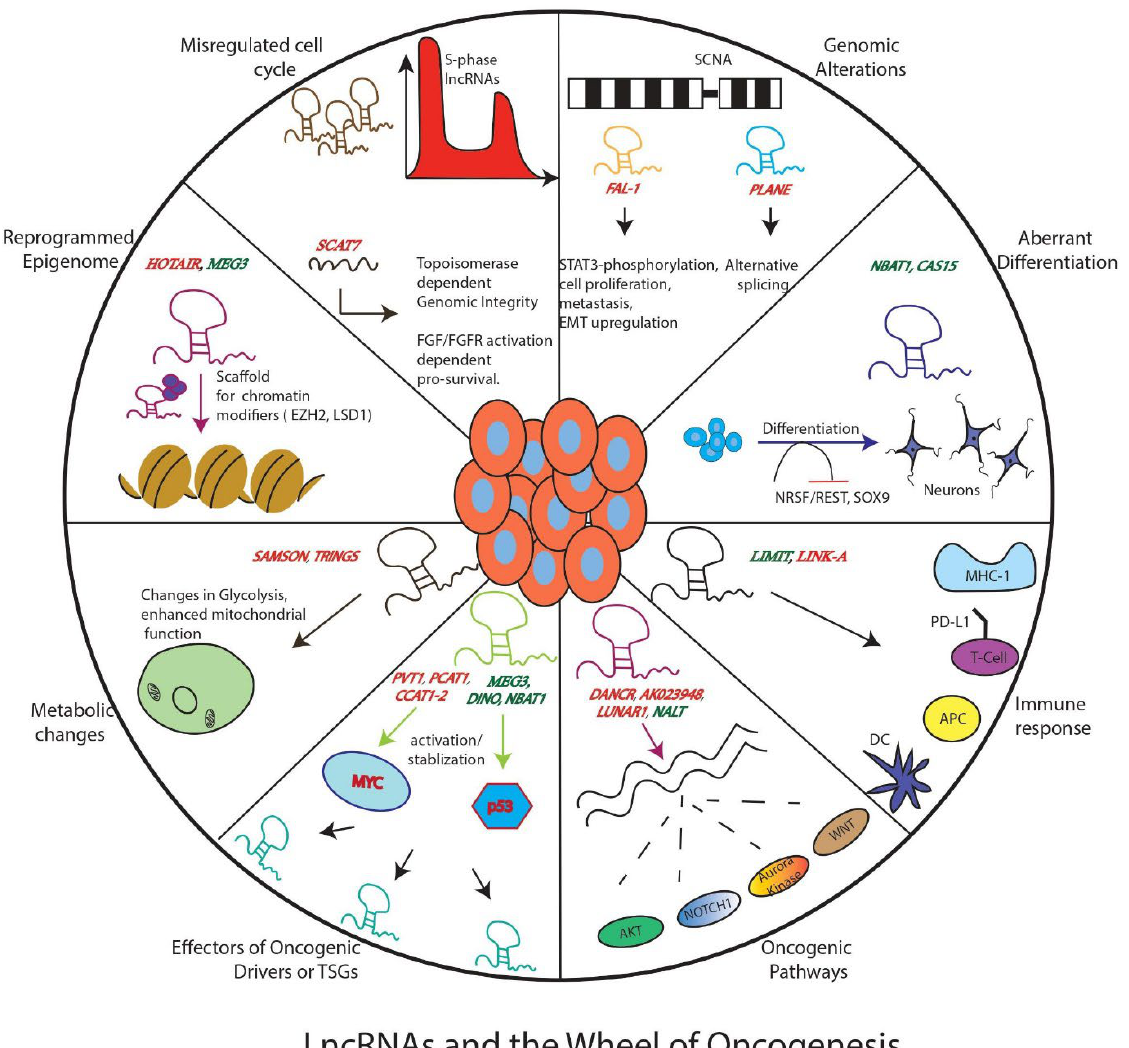
Figure 1. Well known examples of LncRNAs and how they influence key genes, processes, or pathways involved in tumor development. The figure depicts the regulatory role of lncRNAs as either promoters of the wheel of oncogenesis (red) or as brakes (green) inhibiting its movement.